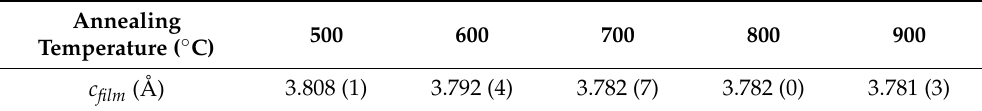
Table 1. The out-of-plane parameter ( c film ) of LCO films with different annealing temperatures. Figure 1. (Color online) The (002) peaks of the LCO epitaxial thin films on (001) STO substrates with Annealing the XRD θ /2 θ symmetric scans.